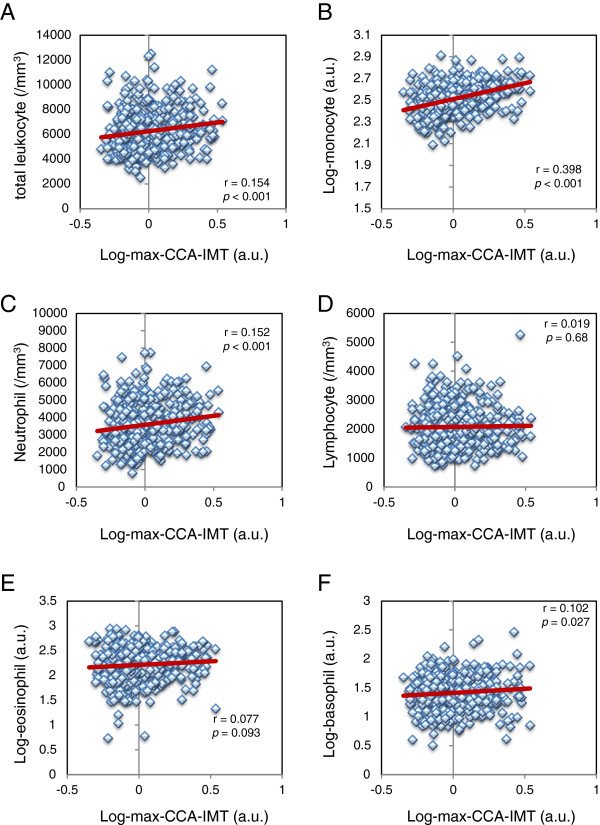
Association of leukocyte subset counts with max-CCA-IMT in patients with type 2 diabetes. A, total leukocyte count; B, monocyte count; C, neutrophil count; D, lymphocyte count; E, eosinophil count; F, basophil count. Since max-CCA-IMT, monocyte count, eosinophil count and basophil count showed skewed distribution, data were logarithmically transformed before the analysis. Units of leukocyte, neutrophil and lymphocytes were/mm3. a.u., arbitrary unit.